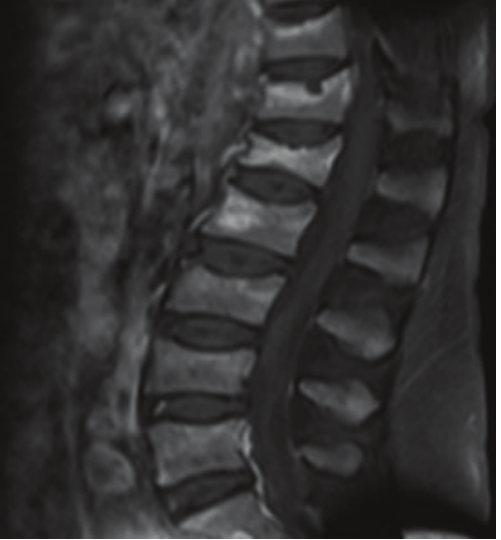
Figure 4: Lumbar spine metastasis on